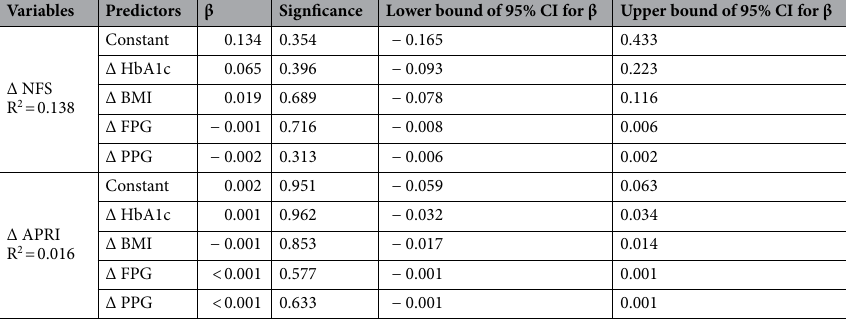
Table 6. The multivariate lineer regression analysis in all subjects of the study. Δ Difference from baseline after exenatide treatment, NFS NAFLD fibrosiz score, APRI AST to Platelet Ratio Index, BMI Body mass indeks, FPG Fasting plasma glucose, PPG Postprandial plasma